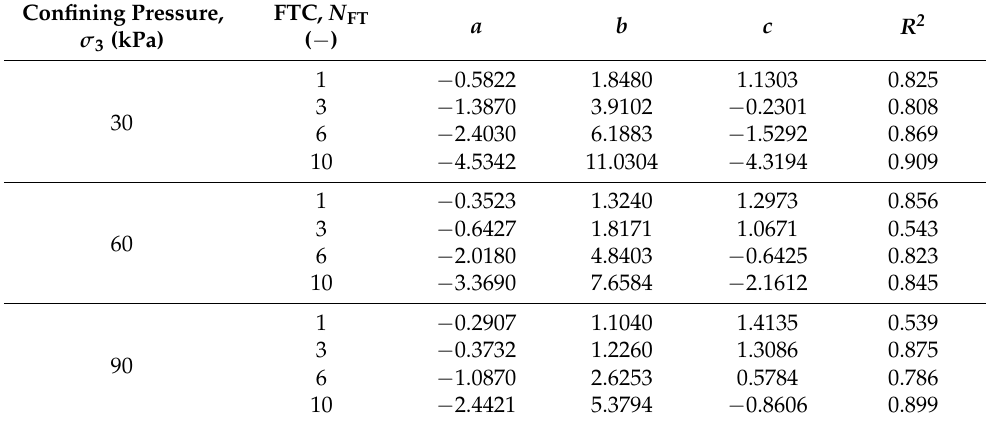
Table 1. Empirical Constants, a , b , and c .